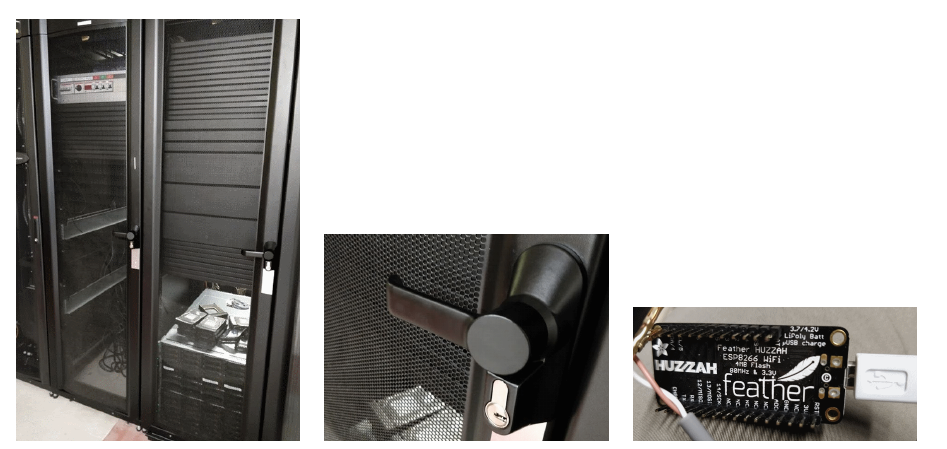
Figure 3: First ISO27001 deployment at